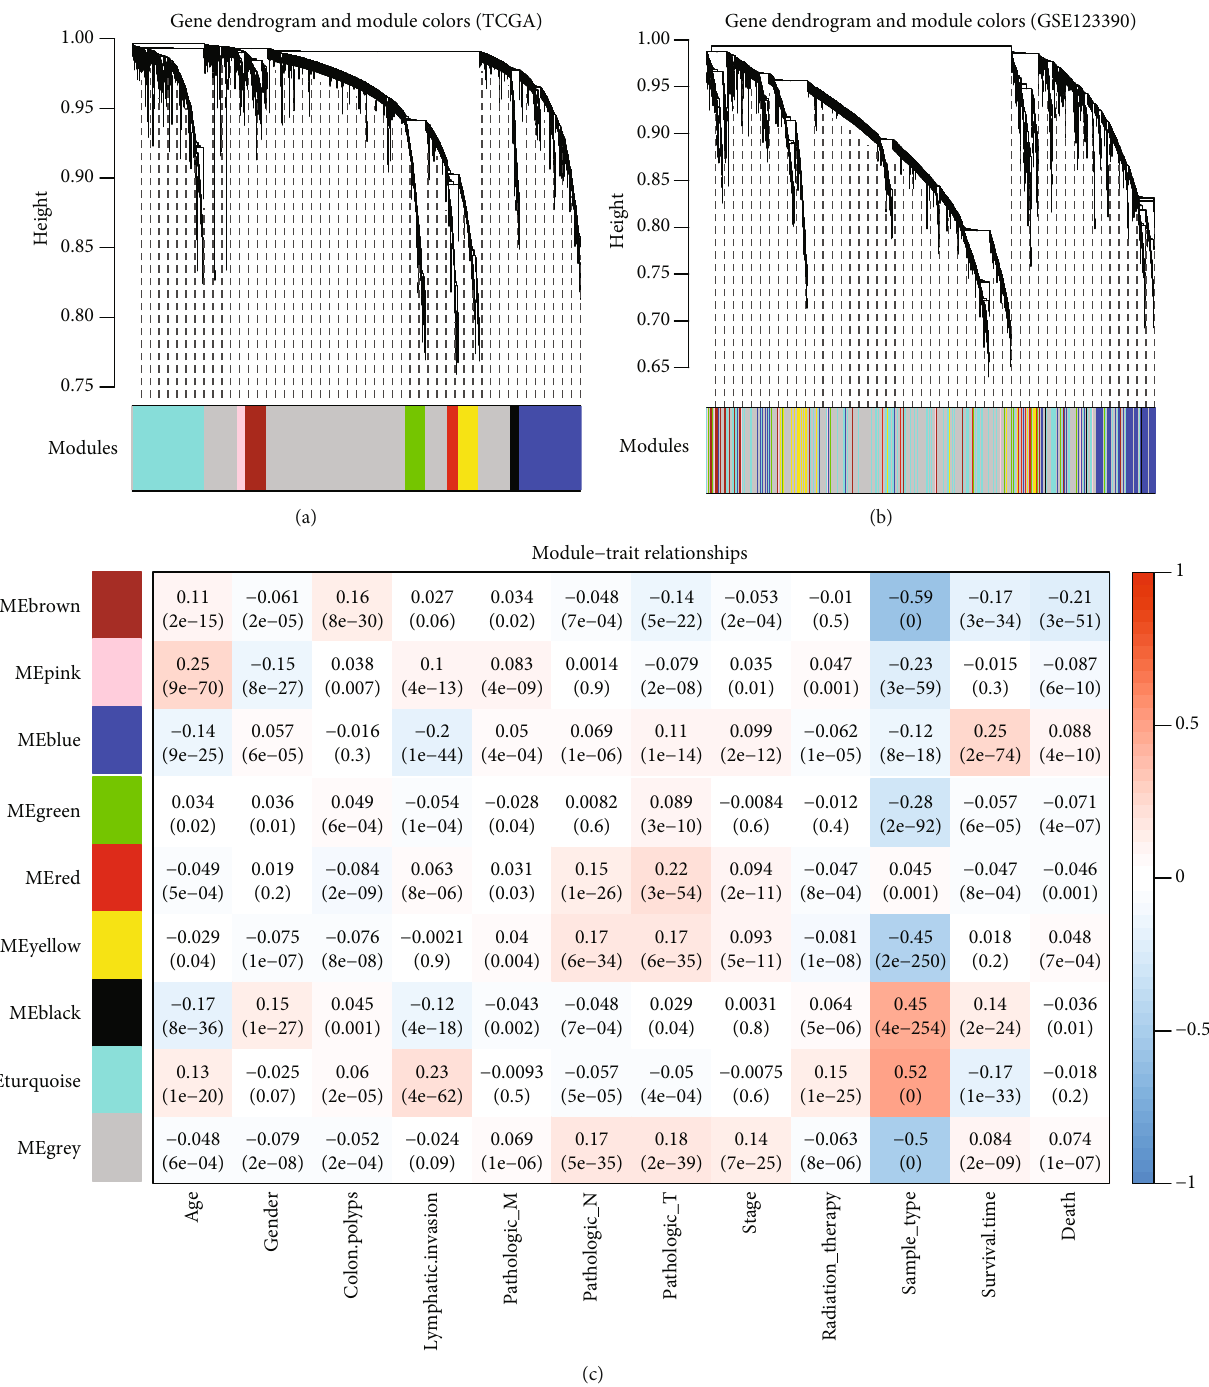
Figure 3: Coexpression modules screened based on the WGCNA. (a) A clustering dendrogram of coexpression modules screened using TCGA dataset. (b) A dendrogram of coexpression modules screened using the GSE123390 dataset. (c) The association between modules and clinical information of rectal